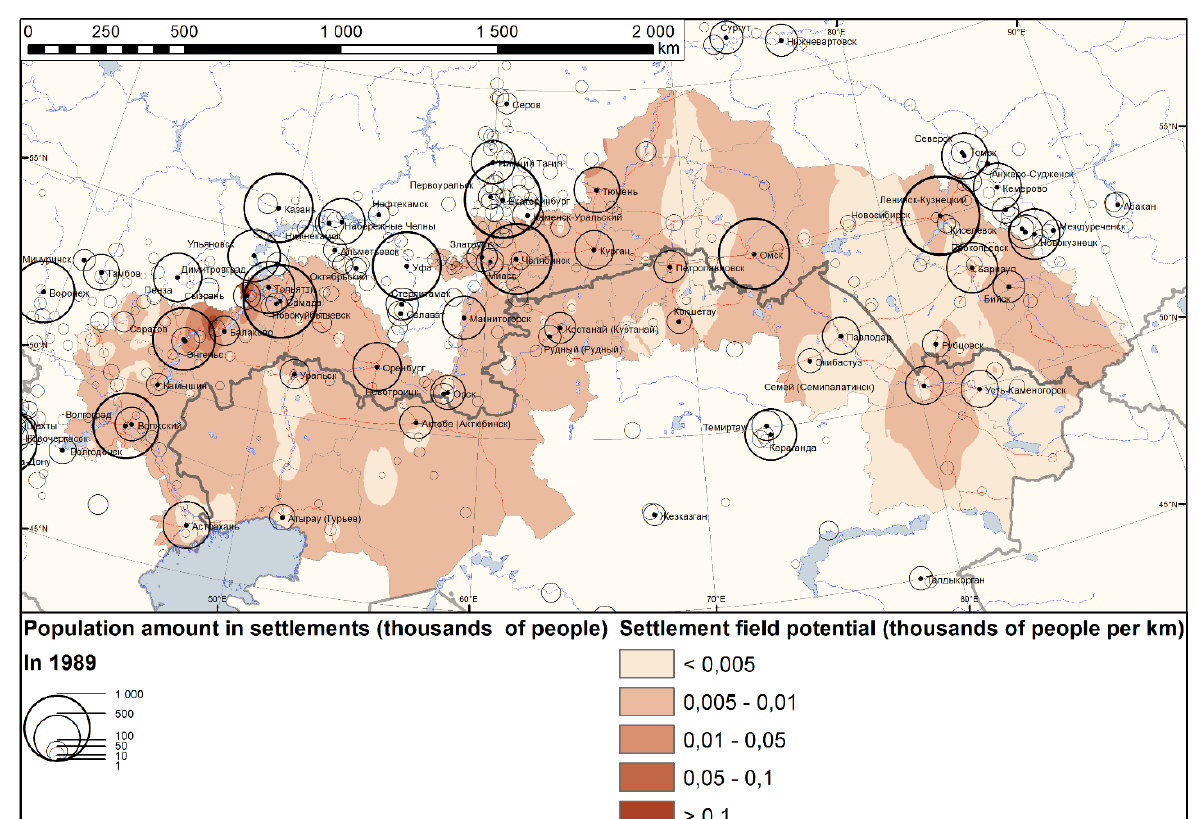
Figure 1 . Draft map visualization of the road-network-based settlement field potential for the Russia-Kazakhstan transborder region. WGS-84/Alberts conic projection. Inverse distance weighting interpolation was used for spatial interpolation of settlement field